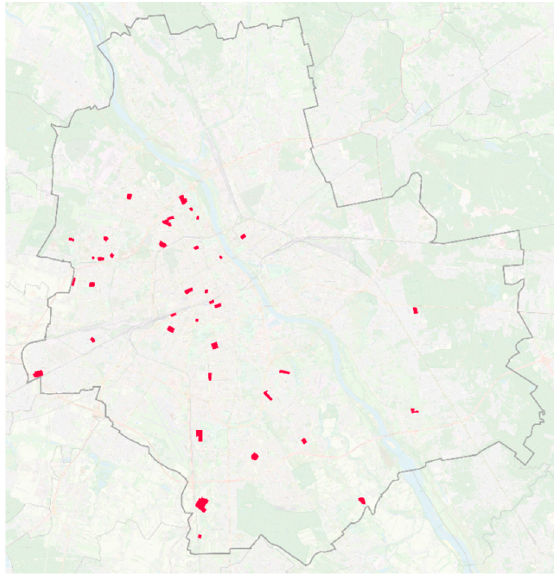
Figure 3. Locations of test quarters in the area of Warsaw. Source: own study.